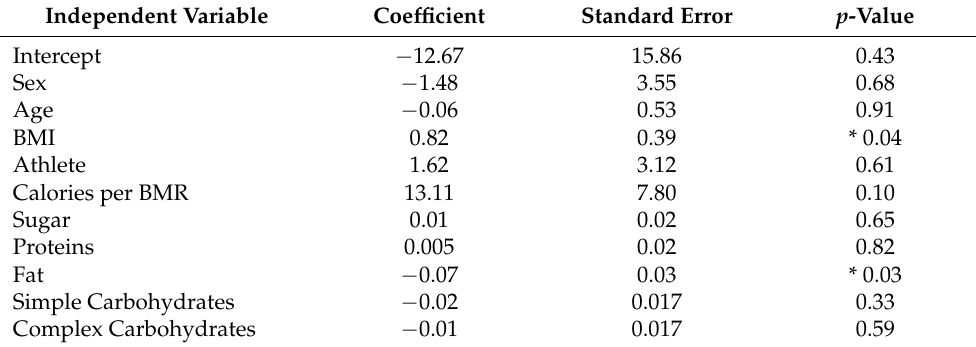
Table 9. Regression results of cortisol change after exercise (dependent variable) and sex, age, BMI, athlete, calories per BMR, sugar, proteins, fat, simple carbohydrates, and complex carbohydrates (independent variables). * p < 0.1. Independent Variable Coefficient Standard Error p -Value Intercept − 12.67 15.86 0.43 − 1.48